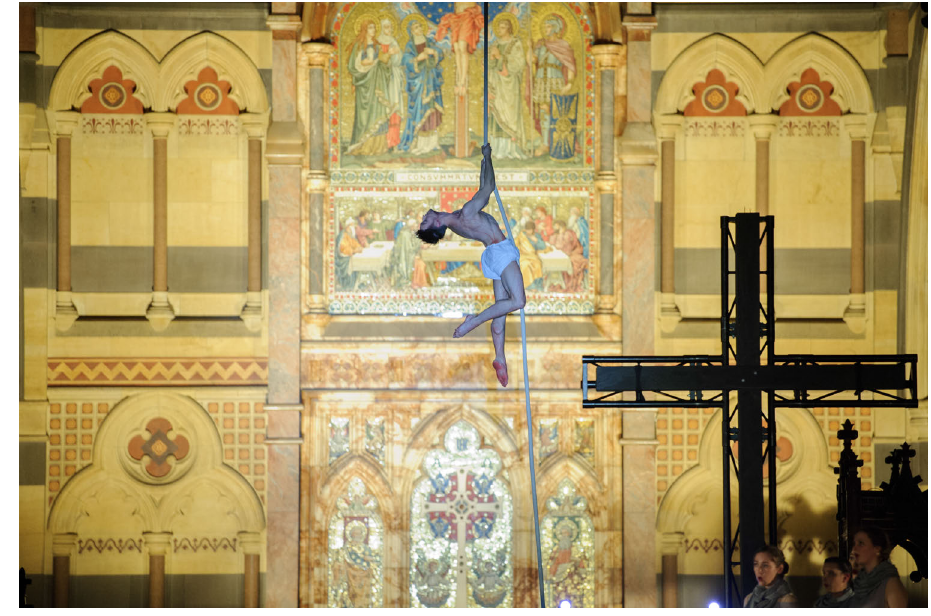
FFigigururee 12.12. The Ascension. (Photo: Sarah Walker)